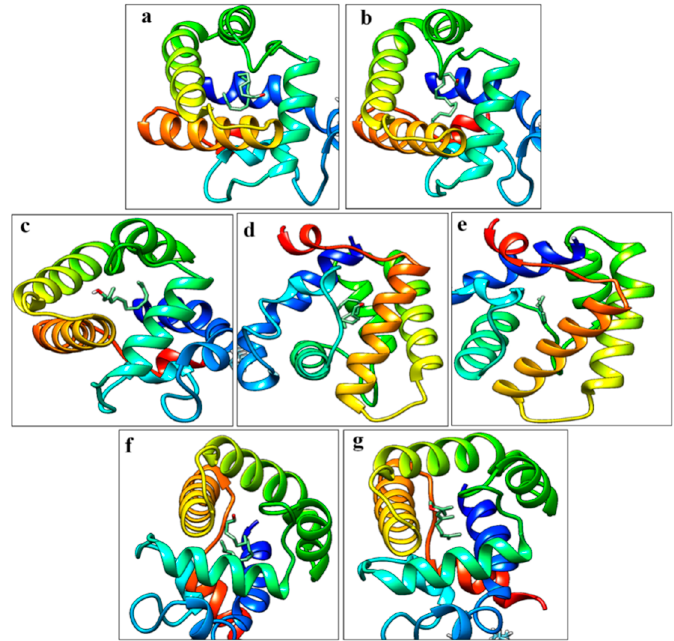
Figure 5. Molecular docking pose of GOBP1 and GOBP2 vs. sex pheromones and volatiles. ( a )–( e ) E10-16:Ald, Z10-16:Ald, farnesol, hexadecanal, and limonene vs. GOBP1 protein whereas ( f ) and ( g ) are Z10-16:Ald, farnesol vs. GOBP2.